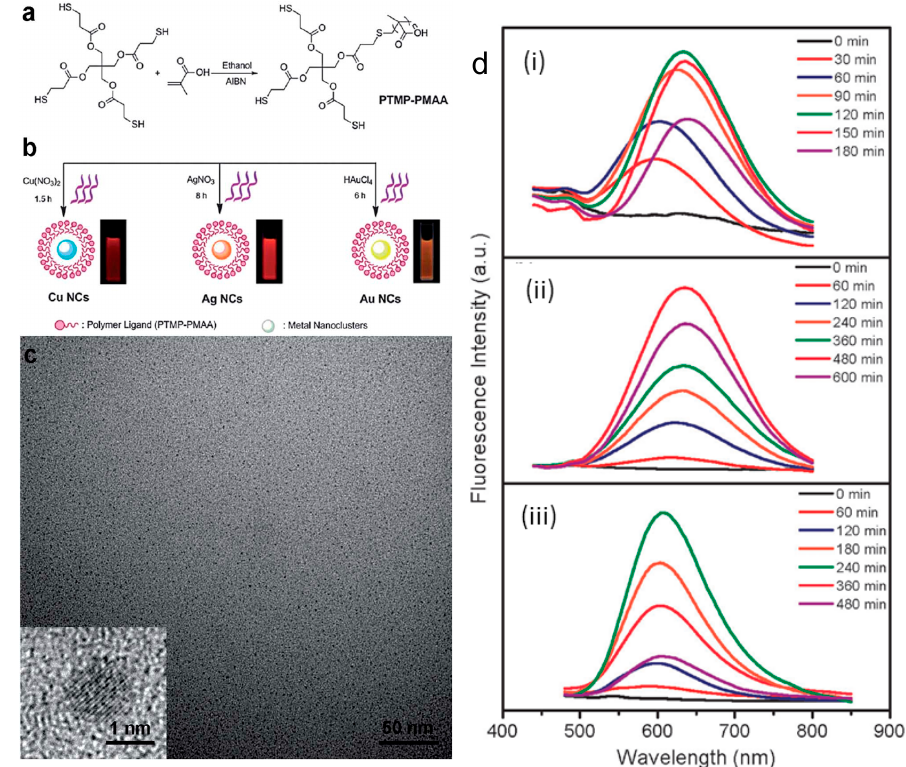
Figure 8. Schematic diagram of preparation of ( a ) the polymer ligand PTMP–PMAA; ( b ) photoreductive synthesis of fluorescent Cu, Ag, and Au nanoclusters; ( c ) TEM image of Au nanoclusters; and ( d ) Time dependent evolution of fluorescence emission spectra of the solution containing ( i ) PTMP–PMAA and Cu(NO 3 ) 2 (excited at 360 nm); ( ii ) PTMP–PMAA and AgNO 3 (excited at 405 nm); ( iii ) PTMP–PMAA and HAuCl 4 (excited at 360 nm) upon UV-irradiation at 365 nm